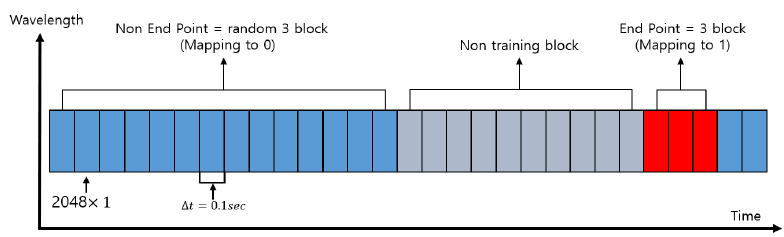
Figure 7. The structure of OES data and the training data selection